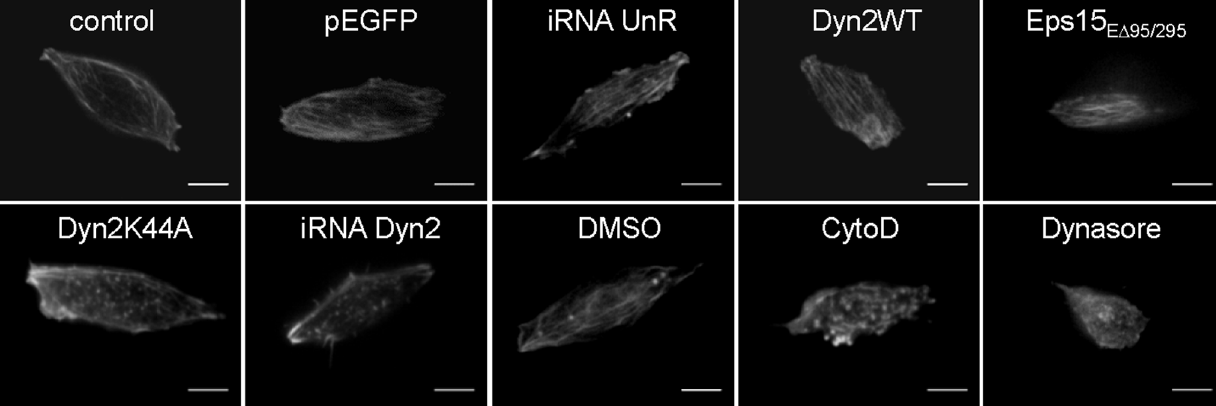
Figure 3. Impaired function or expression of dynamin-2 change F-actin organization pattern. Cells were transfected with Life-act-ruby (n=11) or co-transfected with Life-act-ruby and pEGFP (n=34), iRNA-UnR (n=9) Dyn2WT (n=21), Dyn2K44A (n=31), iRNADyn2 (n=38) or Eps15ED95/295 (n=17) plasmids and visualized by TIRF microscopy 48 h later. To evaluate the effects of a pharmacological inhibition of dynamin, cells transfected with Life-act-ruby were treated with 100 m M dynasore (n=28), or the vehicle DMSO (n=25) during 1 hr at 37 u C. The 81.8% of control cells exhibited a ‘‘normal’’ pattern with clear cortical actin fibers. This value was not significantly different in cells expressing pEGFP (73.6%), iRNA-UnR (88.9%) or Dyn2WT (85.7%) constructs. However, the expression of Dyn2K44A or iRNADyn2, as well as the treatment with dynasore, modified the cortical actin organization and 80.6%, 92.1% and 71.4% of the cells, respectively, exhibited a ‘‘punctuate’’ pattern. The treatment with 4 m M CytoD during 10 minutes at 37 u C produced exactly the same effect: 84.6% of the cells displayed a ‘‘punctuate’’ pattern. Eps15ED95/295 expression did not alter actin organization (82.4% of cells exhibited a normal pattern), indicating that dynamin, but not of endocytosis disruption, modified the actin cytoskeleton pattern. Scale bar=5 m m.